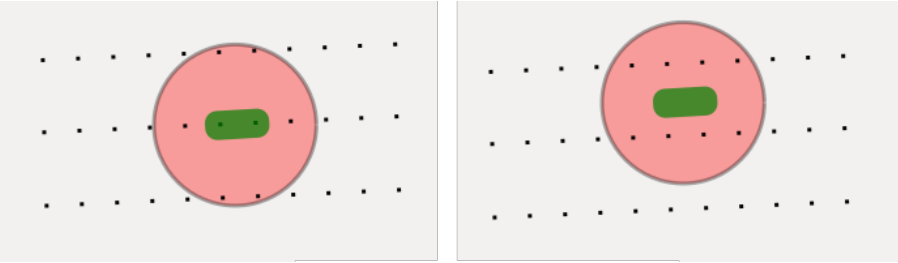
Figure 4. Examples of the circumference lane positioning method. ( left ) Vehicle moving in the lane; ( right ) Vehicle between two lanes.